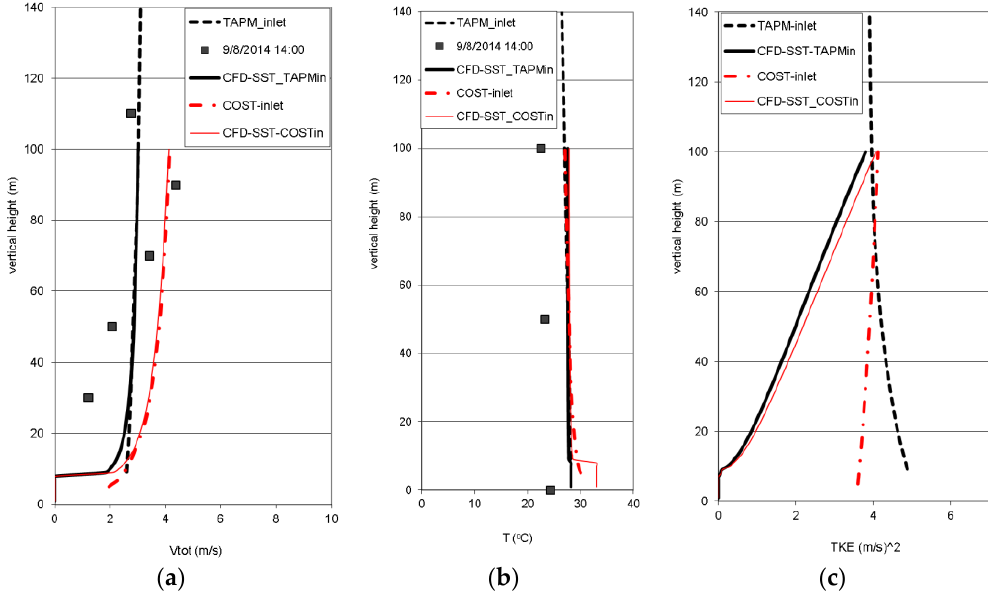
Figure 9. ( a ) Vertical profiles of wind speed and ( c ) wind turbulence kinetic energy over position 2 and ( b ) air temperature over position 1 (Figure 1). CFD results, neutral atmosphere (B in Table 1), SST turbulence model and inlet profiles from mesoscale results (“TAPM - inlet”) and from the COST 710 recommendations (“COST - inlet”) .